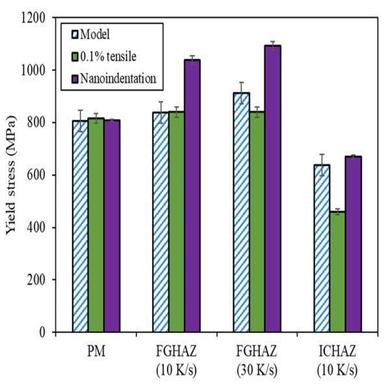
Modelled vs. experimental YS results. HAZ results are based on Gleeble-simulated materials, excluding the ICHAZ, which is from aswelded material.